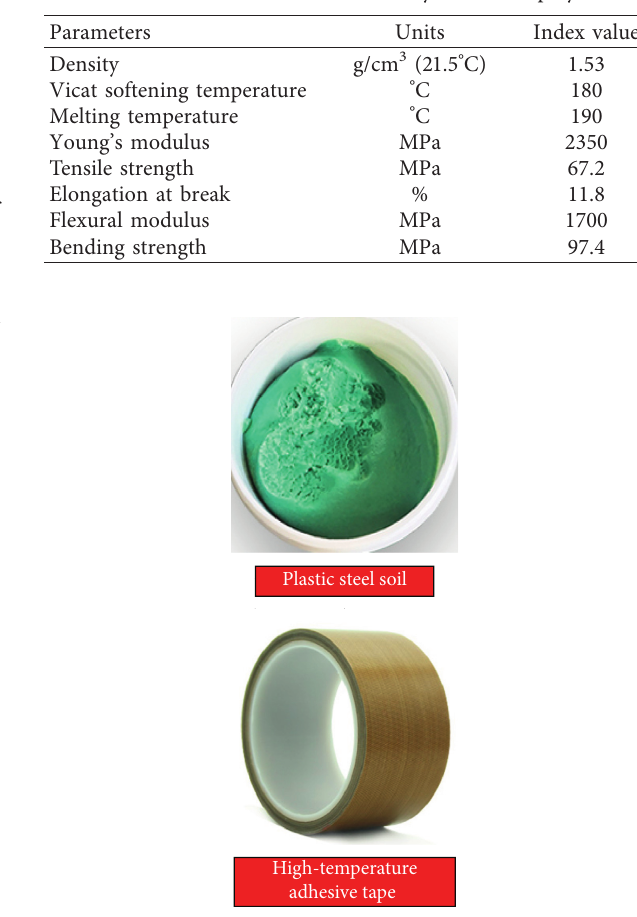
Figure 1: Internal insulation layer materials.